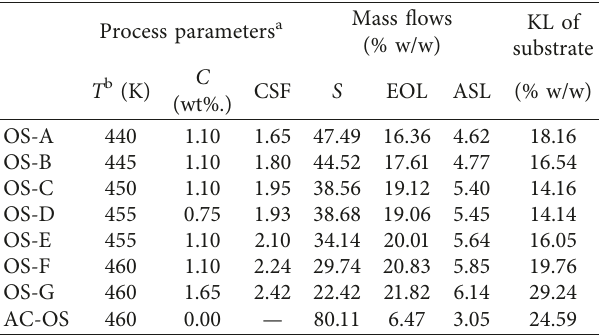
Table 2: Process parameters, mass flows of the organosolv ex- traction experiments, and lignin content of the solid